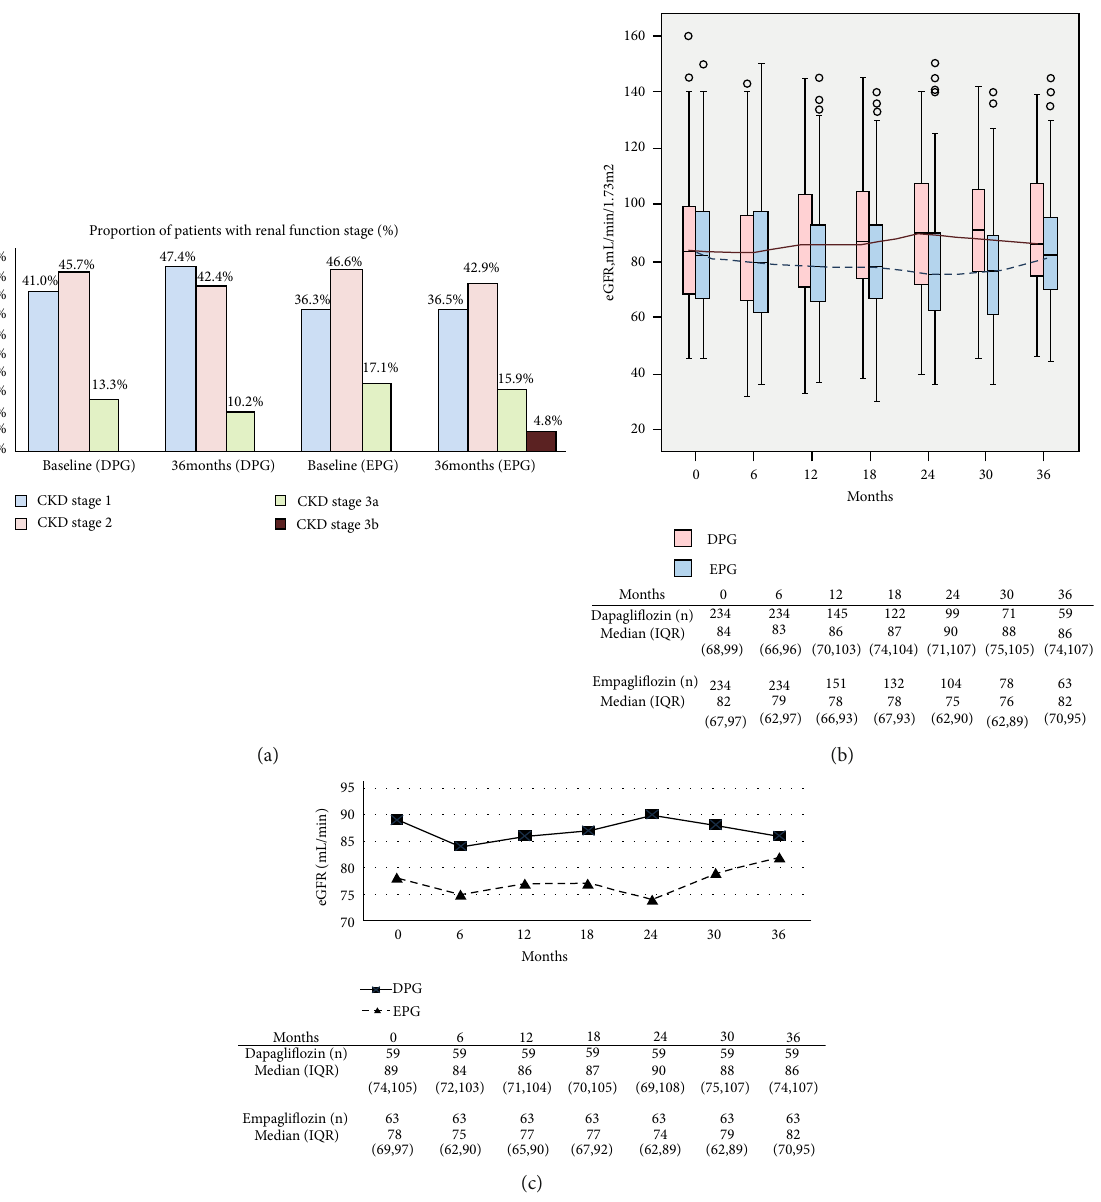
Figure 3: Long-term tracking of eGFR-related data; eGFR: estimated glomerular fi ltration rate (mL/min/1.73m 2 ); DPG: dapagli fl ozin; EPG: empagli fl ozin. (a) Proportion of patients with di ff erent renal function stages at 0 and 36 months. Range of eGFR values by bars: CKD stage 1: ≥ 90; CKD stage 2: 60 ~ 89; CKD stage 3a: 45 ~ 59; CKD stage 3b: 30 ~ 44 (mL/min/1.73m 2 ). (b) Box plots indicate the eGFR values compared to baseline levels after 6, 12, 18, 24, 30, and 36 months of treatment. (c) Change in clinical parameters from baseline values to 36 months for long-term